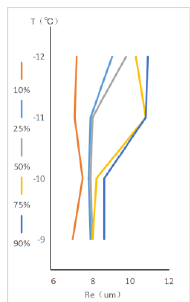
Figure 11. T-Re profiles at 12:30 LST